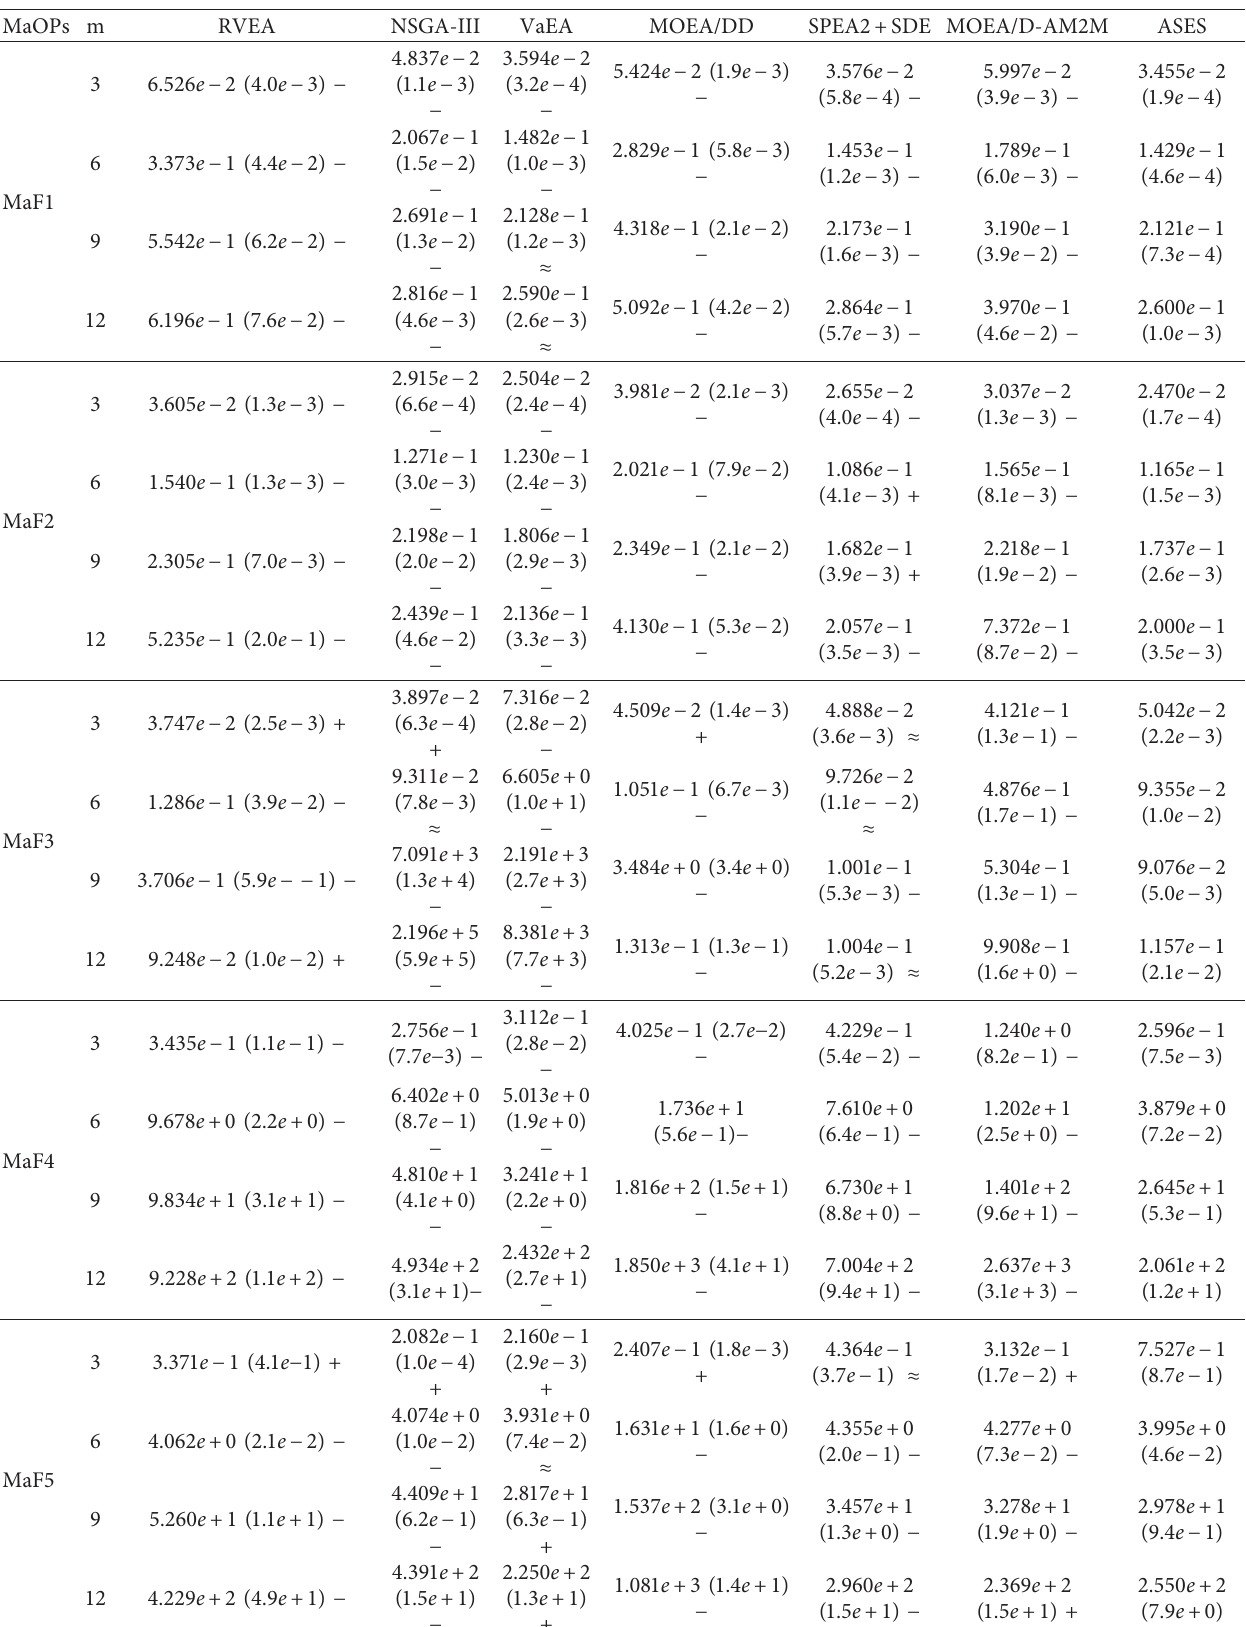
Table 1: Comparison of IGD values of the seven algorithms on solving 3-, 6-, 9-, and 12-objective test functions MaF1–MaF13. MaOPs m RVEA NSGA-III VaEA SPEA2 +SDE MOEA/D-AM2M